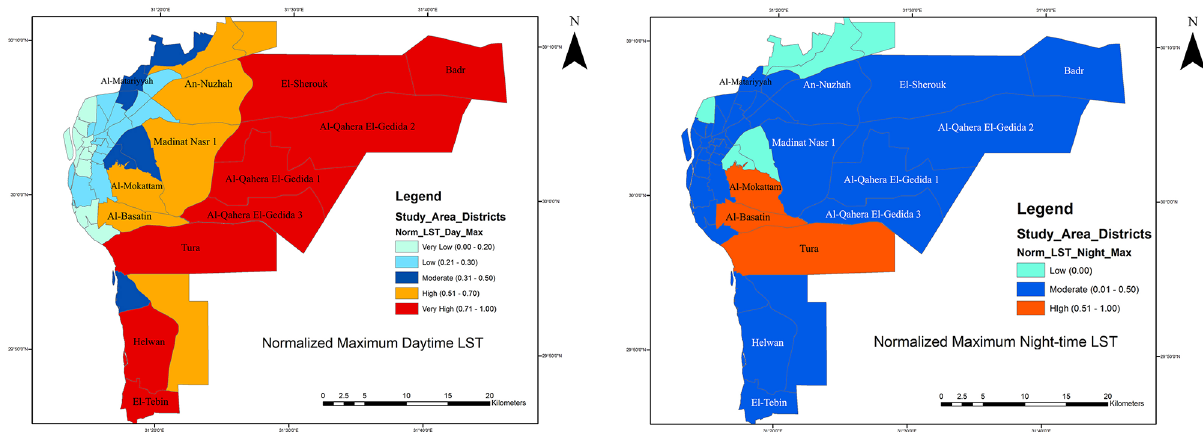
Fig. 7. Normalized maximum day-time LST (right) and night-time (left). Source: (Author).